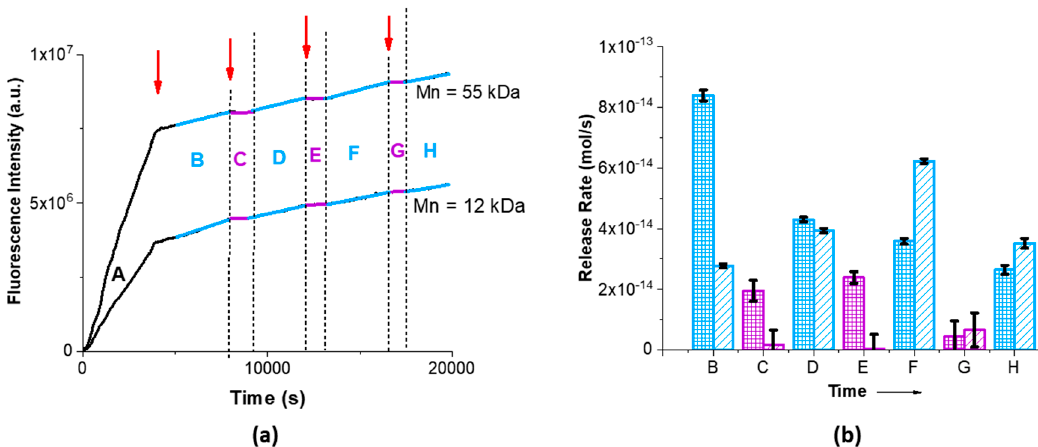
Figure 4. ( a ) Fluorescence intensity of SRB released from SRB-loaded core-shell MSN-pDAEM nanoparticles with polymer chains of M n = 55 kDa and M n = 12 kDa, MSN-pDAEM55 and MSN-pDAEM12 respectively, that diffuses across the dialysis membrane (solid black lines,